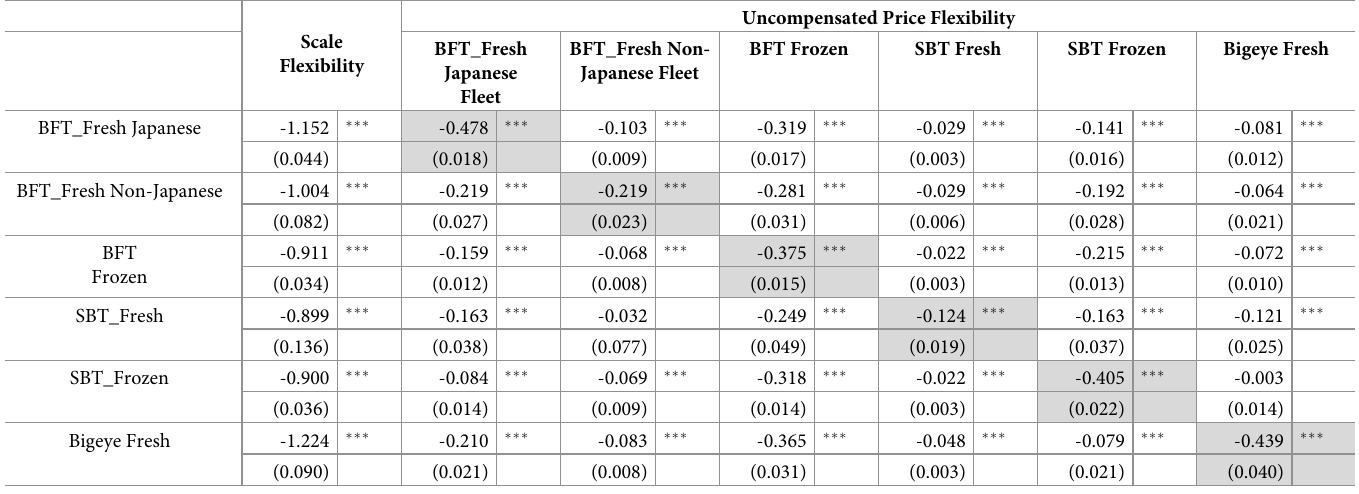
Table 3. The scale, uncompensated own-quantity flexibility and uncompensated cross-quantity flexibility of the tuna sashimi market in Tokyo,